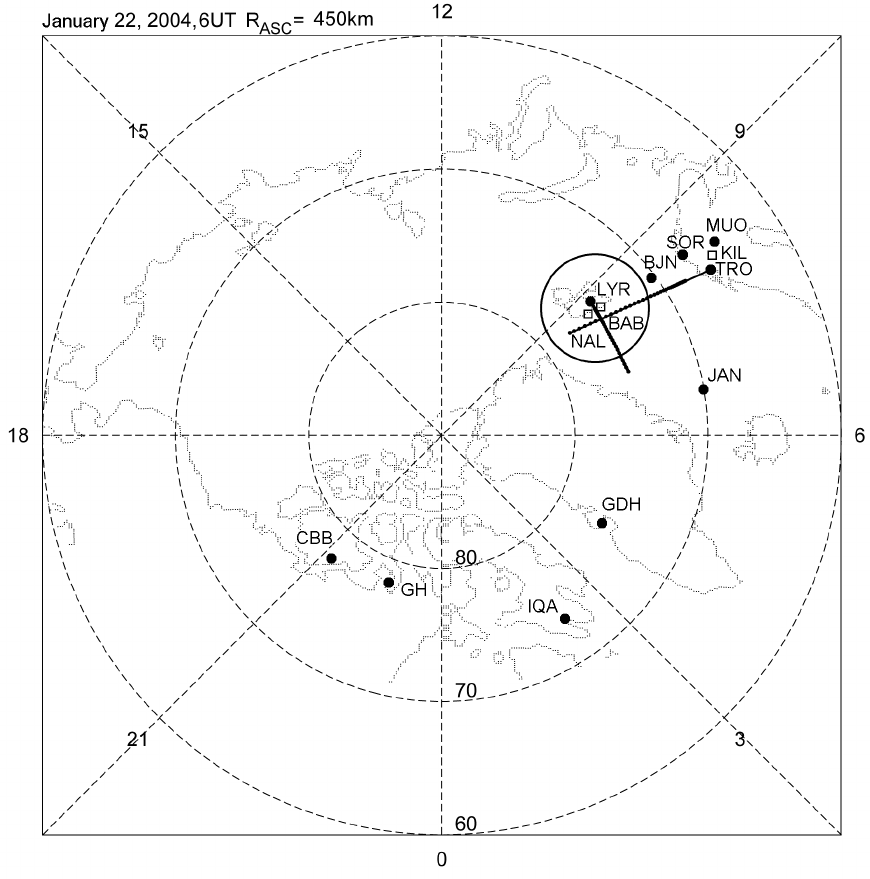
Fig.1. Location of observational points. Black circles indicate magnetic observatories, open squares show the location of optical instruments, large circle is the BAB TV camera field of view, the EISCAT Svalbard and the EISCAT UHF beams are shown with bold lines .